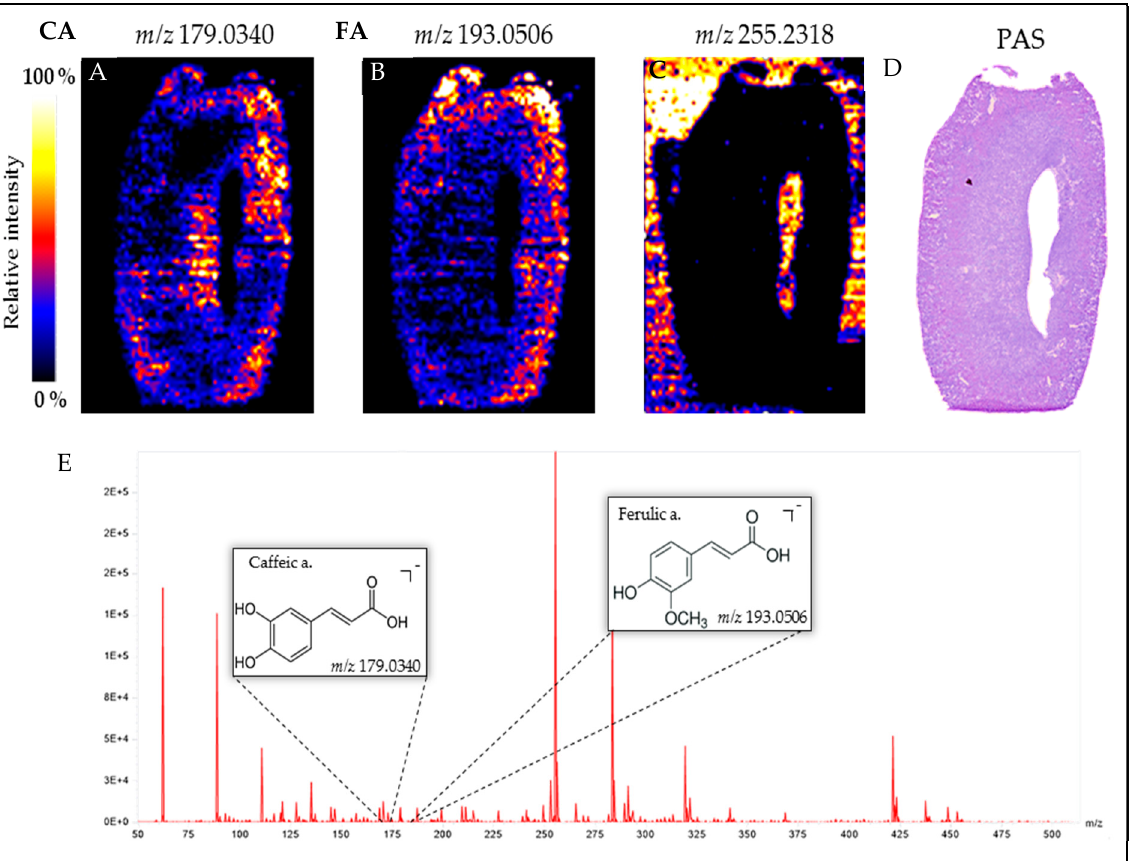
Figure 8. Visualization of caffeic acid (CA) and its circulating metabolite, ferulic acid (FA), 1 h post oral administration of CA 25 mg/kg in the obstructed kidney tissue of mice. Desorption electrospray ionization-high resolution/mass spectrometry (DESI-HR/MS) Imaging of ( A ) caffeic acid ( m/z 179.0340), ( B ) ferulic acid ( m/z 193.0506) and ( C ) m/z 255.2318 used to show the negative fingerprint of tissue and the corresponding Periodic Acid Schiff (PAS) staining ( D ). ( E ) DESI-HR/MS mass spectrum ranging from m/z 50 to 500. The Synapt Blue-Red-Yellow color scale was used.